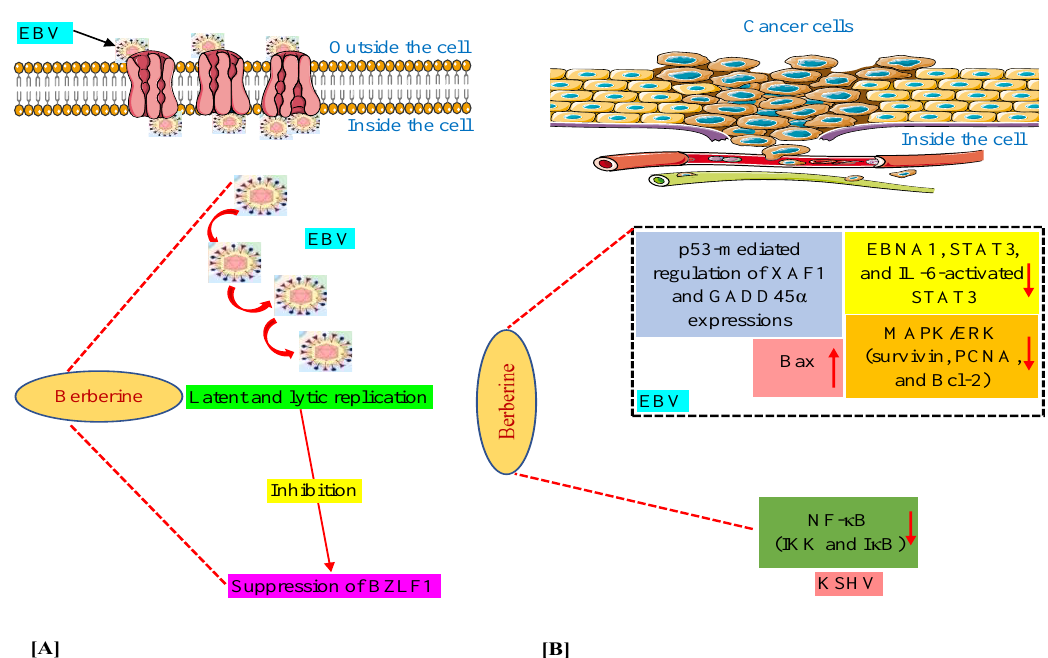
Figure 2. Mechanisms of berberine against EBV replication ( A ) and EBV- and KSHV-associated cancers ( B ). The upward-pointing arrow indicates enhancement/upregulation, and the downward-pointing arrow indicates inhibition/downregulation. EBNA1, Epstein–Barr nuclear antigen 1; EBV, Epstein–Barr virus; GADD45α, growth arrest and DNA damage inducible alpha; IKK, IκB kinase; IL-6, interleukin-6; KSHV, Kaposi’s sarcoma-associated herpesvirus; MAPK/ERK, mitogen-activated protein kinase/extracellular signal-regulated kinase; NF-κB, nuclear factor kappa B; PCNA, proliferating cell nuclear antigen; STAT3, signal transducer and activator of transcription 3; XAF1, X-linked inhibitor of apoptosis protein-associated factor 1.